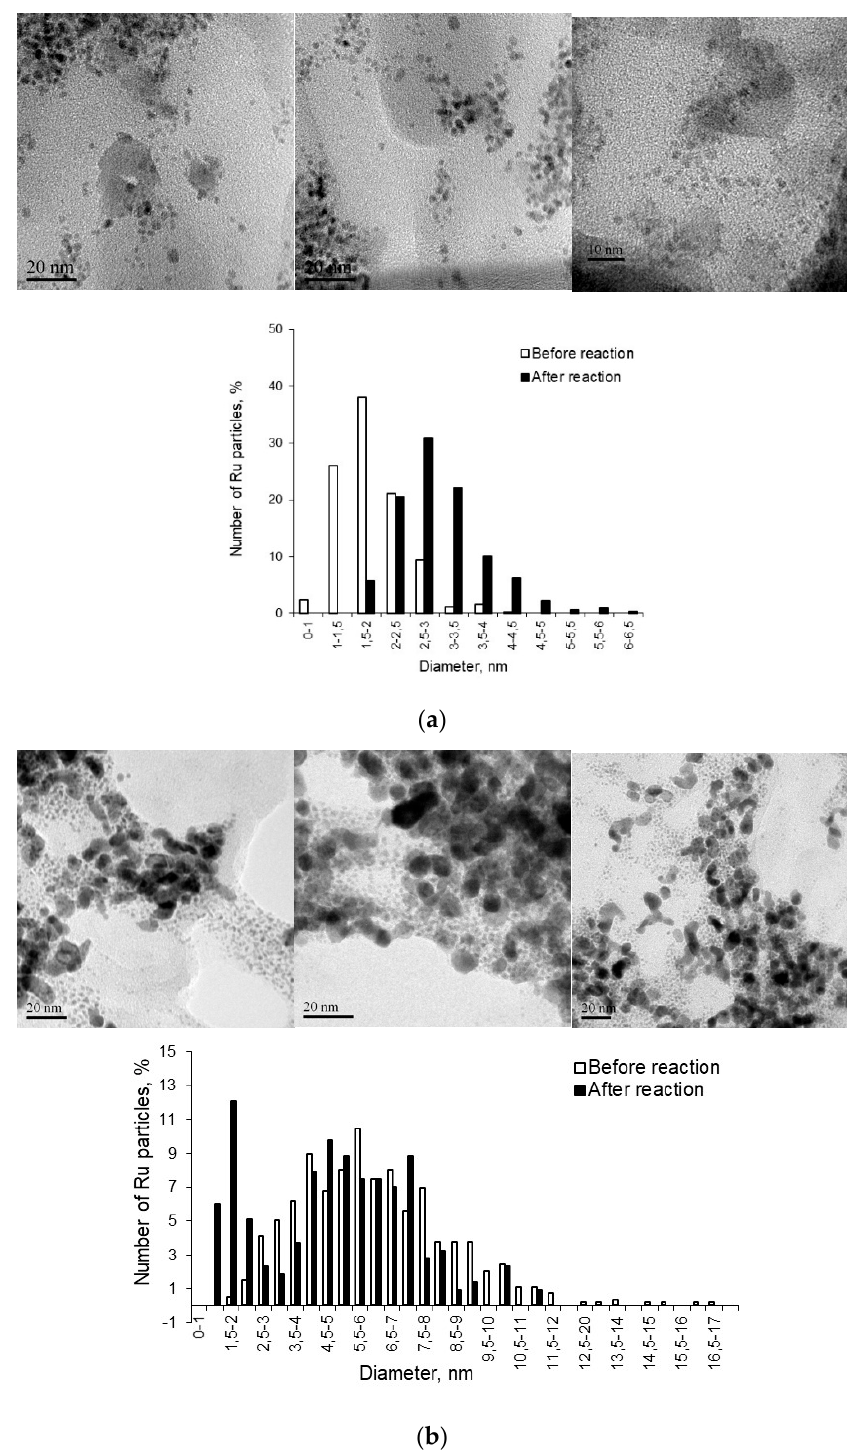
Figure 11. TEM images of the catalysts used and a comparison of the size distributions of the fresh and used catalysts: ( a ) Ru / TiO 2 and ( b ) Pt / ZrO 2